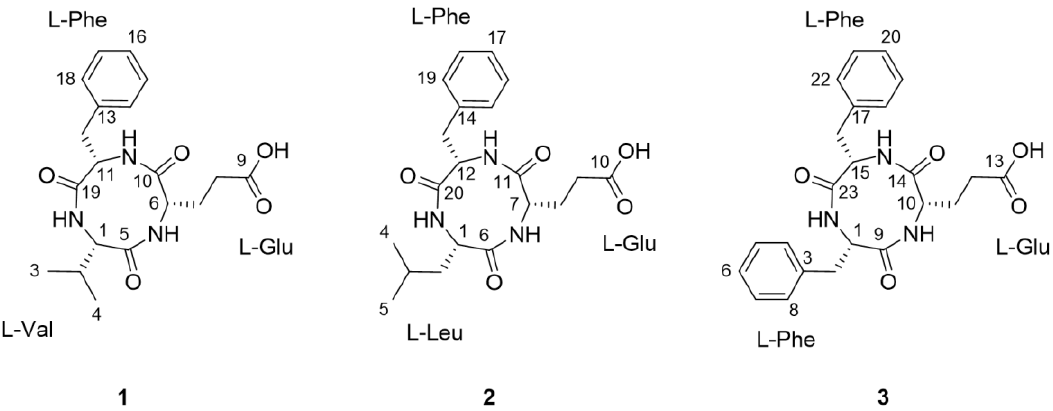
Figure 1. The chemical structures of natalenamides A–C (compounds 1 – 3 ) .